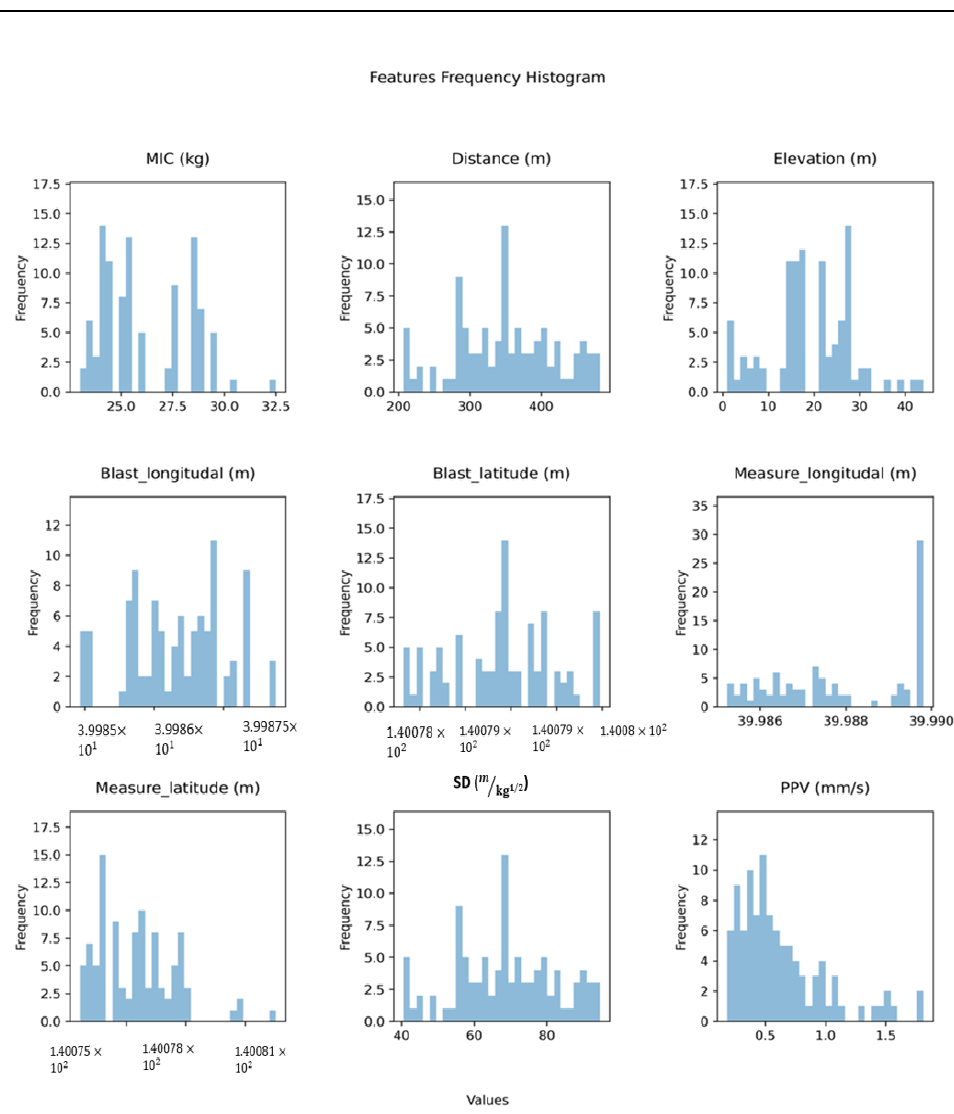
Figure 5. Frequency distribution of the ground vibration dataset.